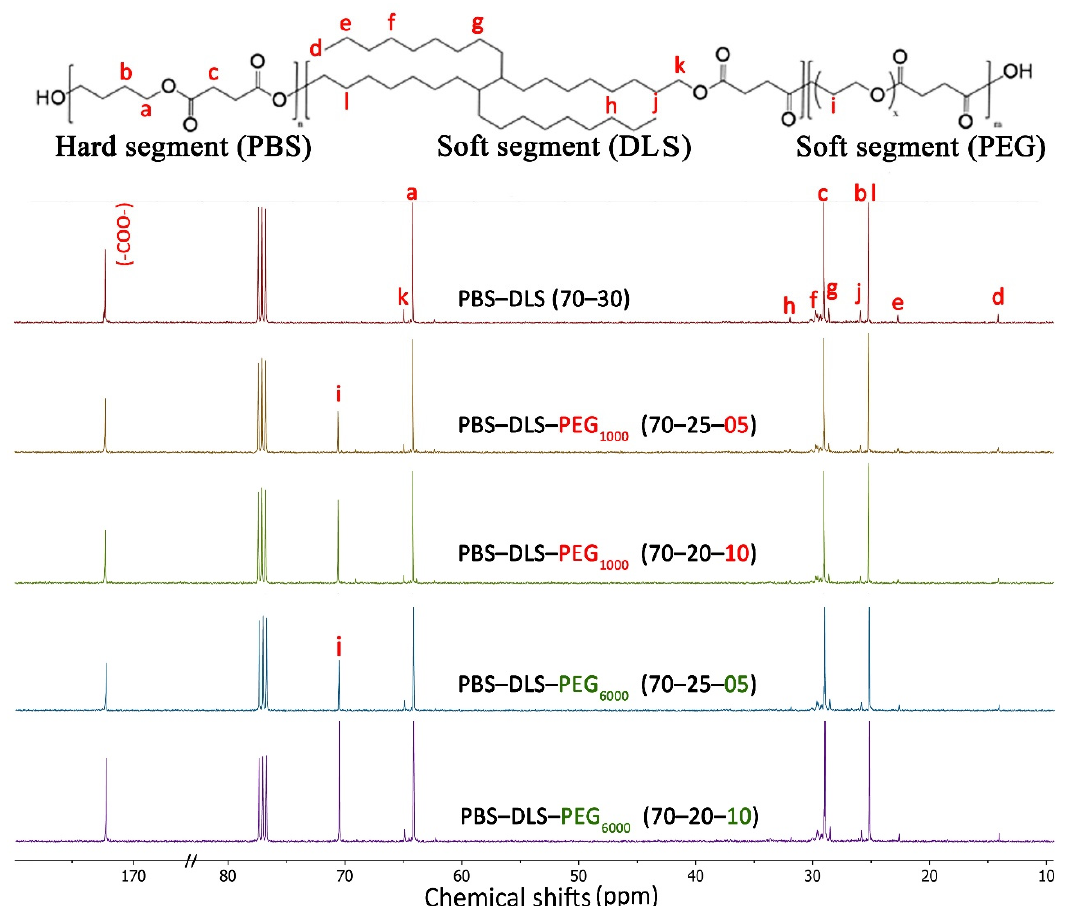
Figure 3. 13 C NMR spectra of synthesized PBS-DLS, PBS-DLS-PEG 1000 and PBS-DLS-PEG 6000 of different segmental compositions.